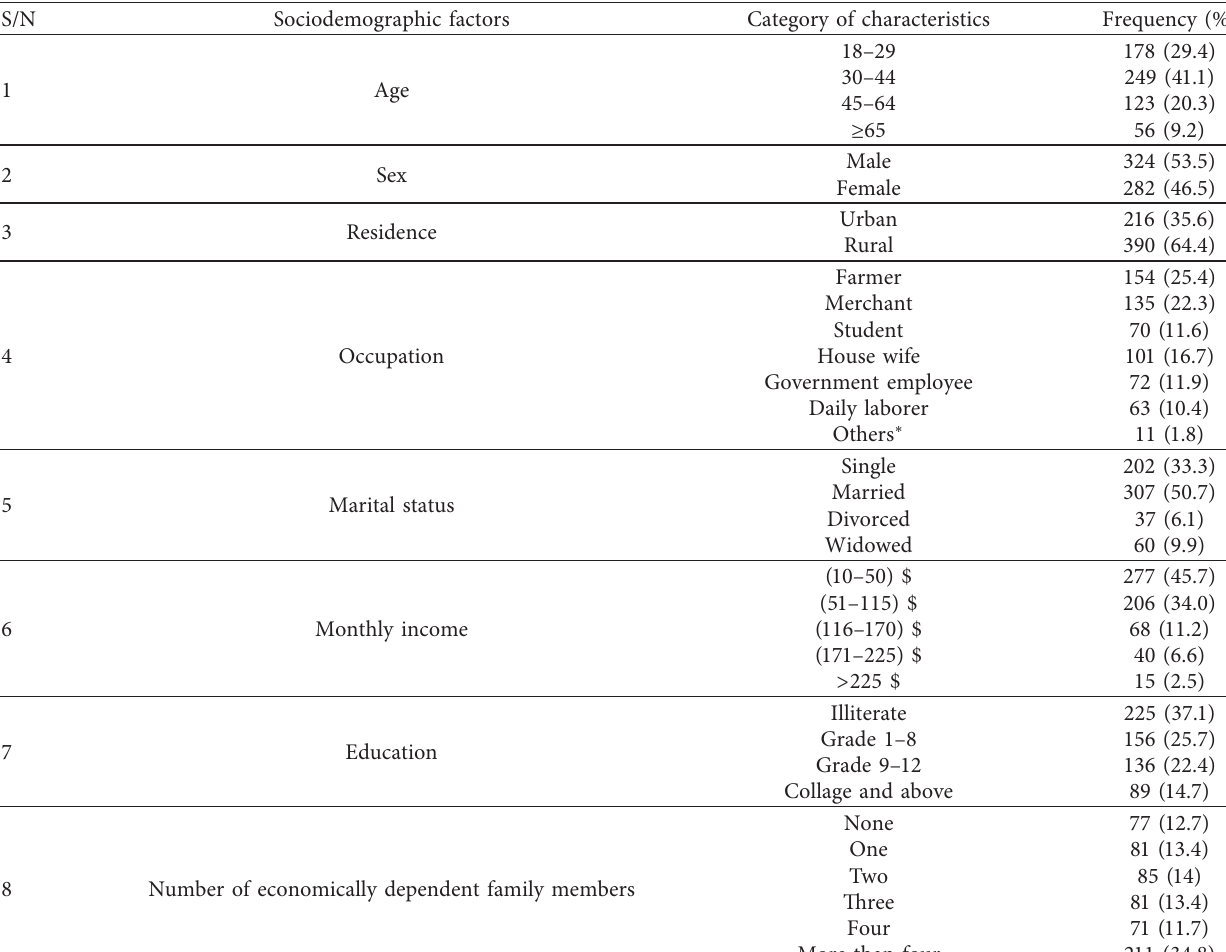
Table 1: Sociodemographic and socioeconomic characteristics of patients in Jimma Zone public health facilities, May 2018.